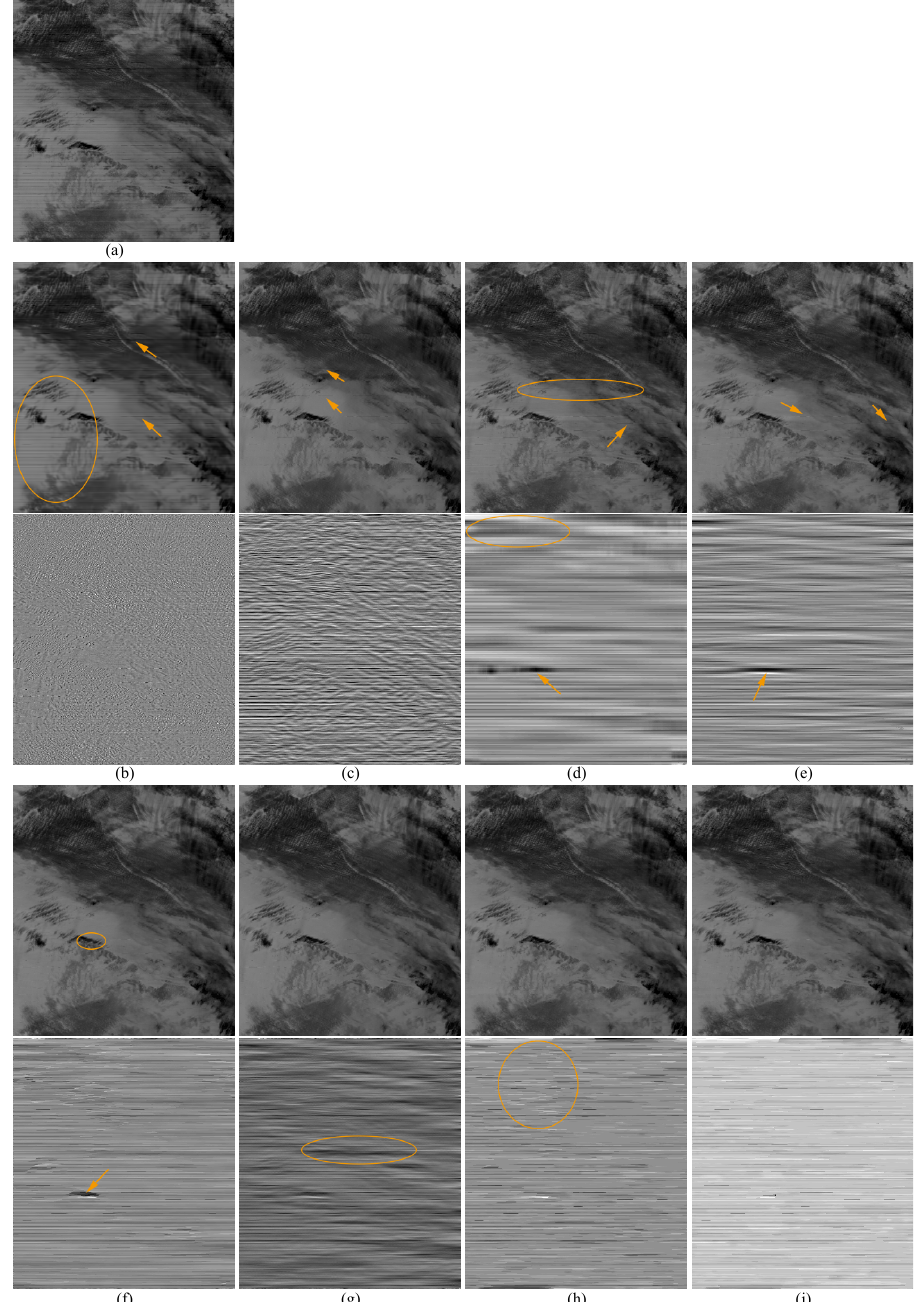
Figure 20. Results of different methods on Terra MODIS data band 28 R4. ( a ) original; ( b ) BM3D; ( c ) SNRCNN; ( d ) GF-based; ( e ) WAFT; ( f ) UV; ( g ) HUTV; ( h ) SUV; ( i ) WDSUV. In each result, the top part is the destriping result, and the bottom part is the corresponding stripe noise